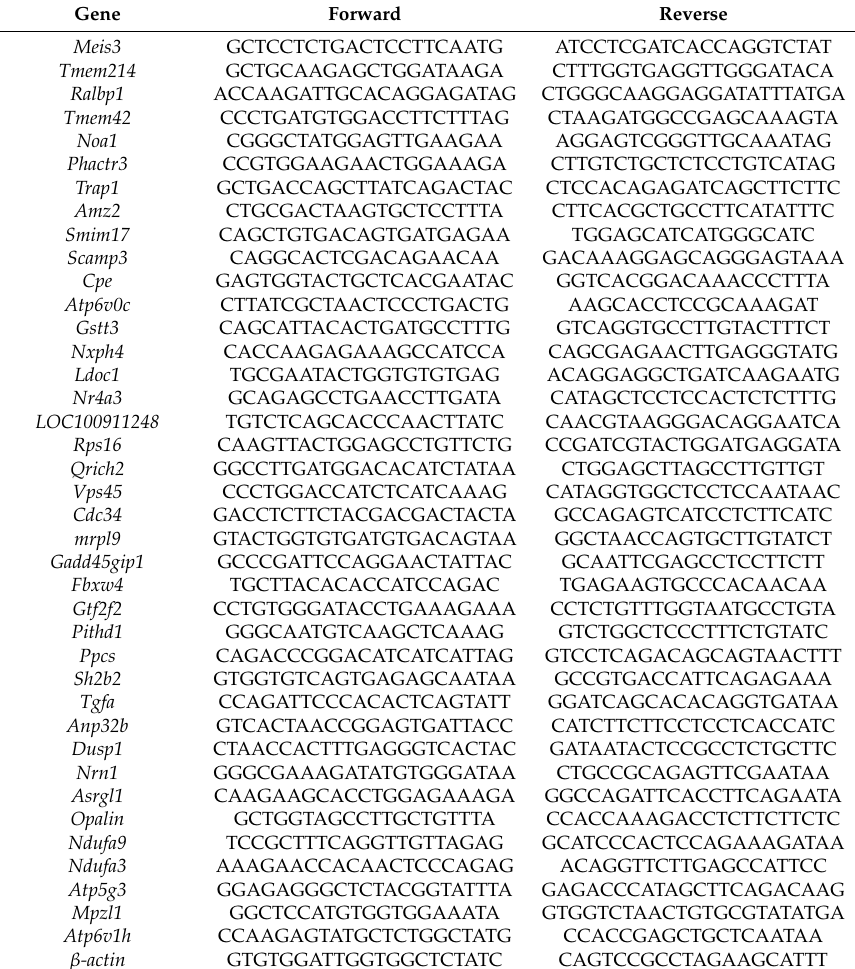
Table A2. qPCR primer